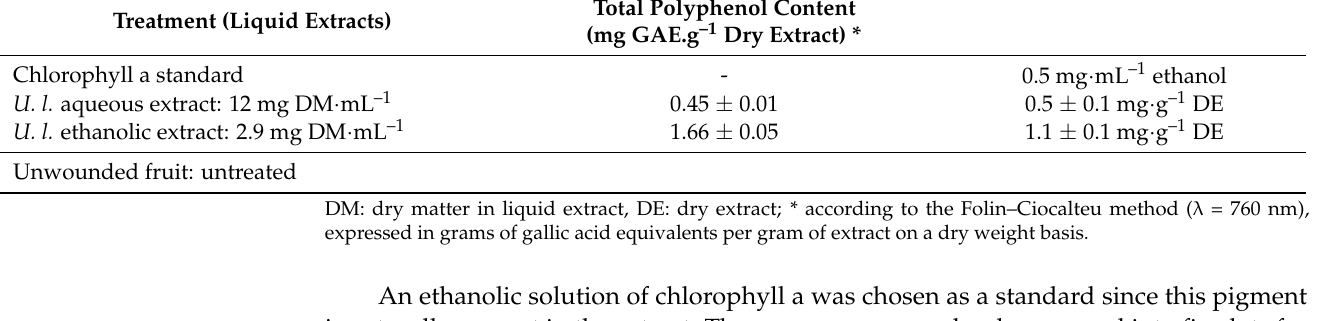
Table 1. Designed samples used for treatment with seaweed liquid extracts (SLEs). Treatment (Liquid